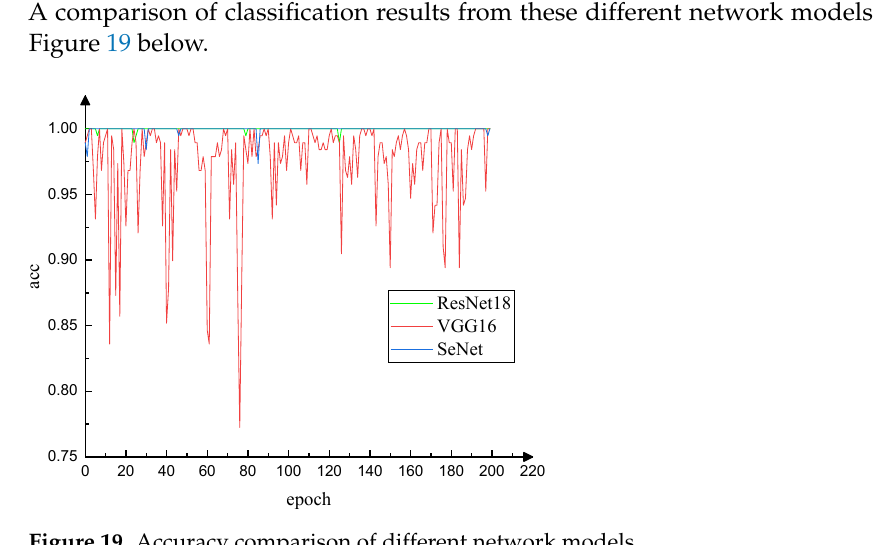
Figure 19. Accuracy comparison of different network models.